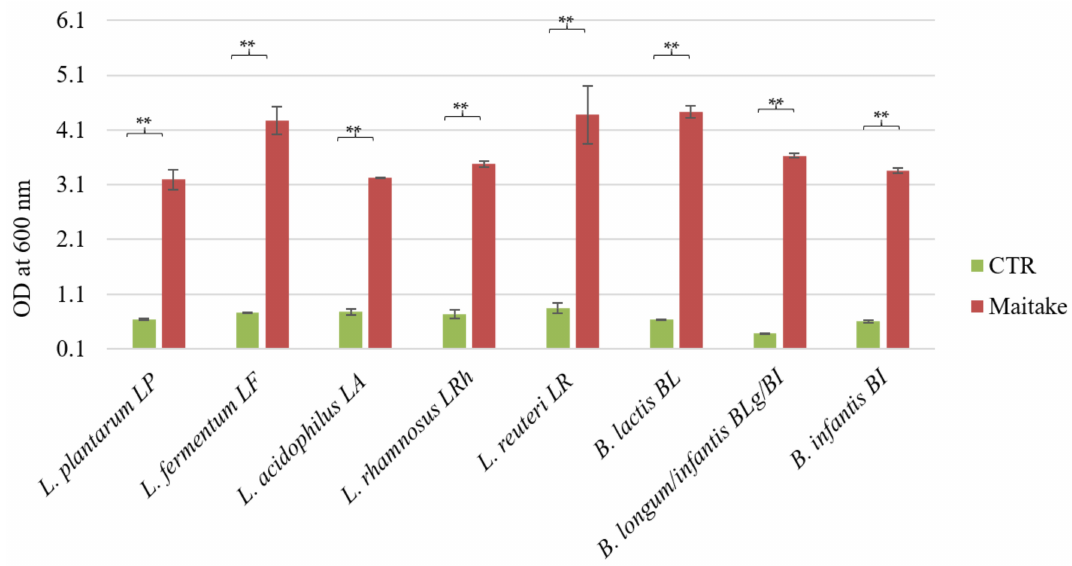
Figure 1. Prebiotic potential of Maitake extract on Lactobacillus and Bifidobacterium strains. The Figure represents the growth of the selected Lactobacillus and Bifidobacterium strains in presence of CTR medium and Maitake extract at a concentration of 2% w / v . Values are represented as mean value of OD at 600 nm ± standard deviation. Statistical differences were calculated using t -Student’s test: ** p -value <